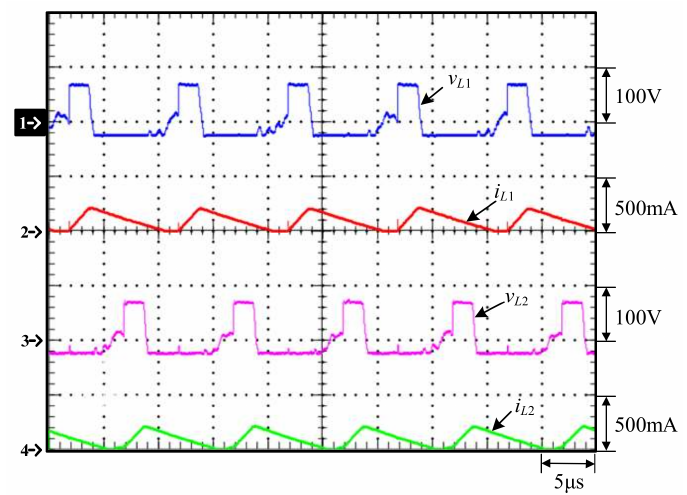
Figure 26. Measured waveforms relevant to 25% of the rated load: (1) v L 1 ; (2) i L 1 ; (3) v L 2 ; (4) i L 2 .